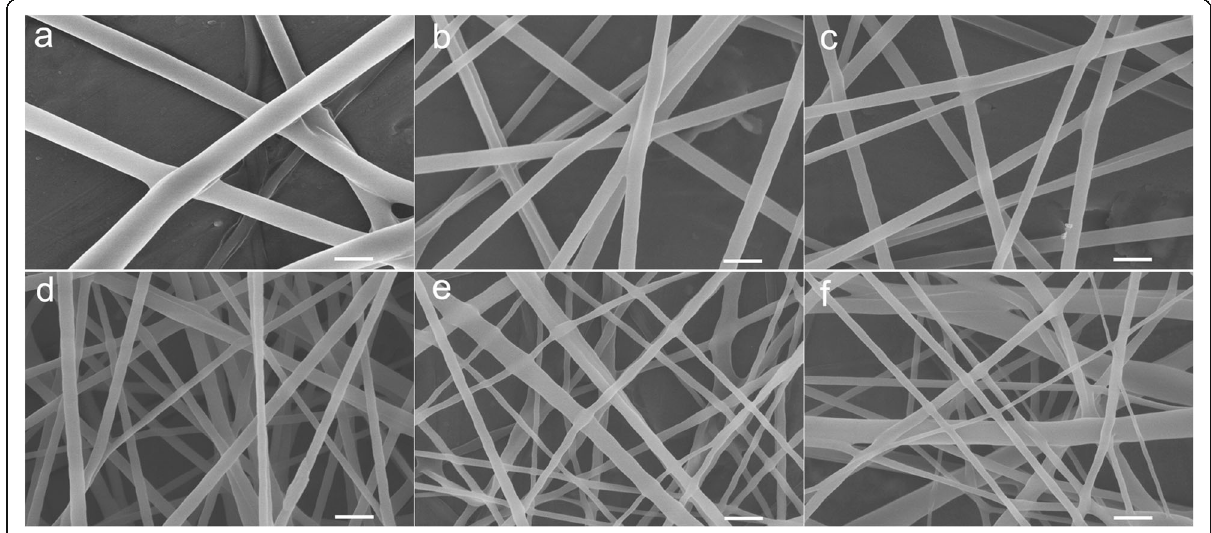
Fig. 7 The morphology of PVA nanofiber under different voltage value a 7 kV, b 10 kV, c 15 kV, d 20 kV, e 25 kV, and f 30 kV (the scale bar is 600